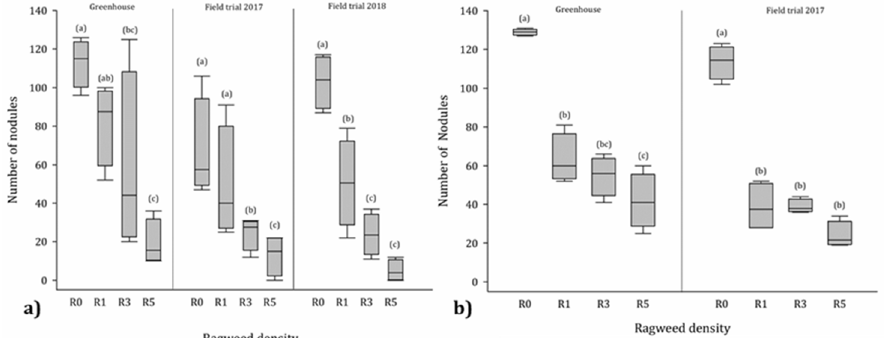
Figure 3. Number of nodules dependent on the ragweed density (0, 1, 3, and 5 plants: R0, R1, R3, and R5) of ( a ) cultivar Albenga and ( b ) cultivar ES Mentor, separated by trial (n = 4; different letters indicate significant differences).